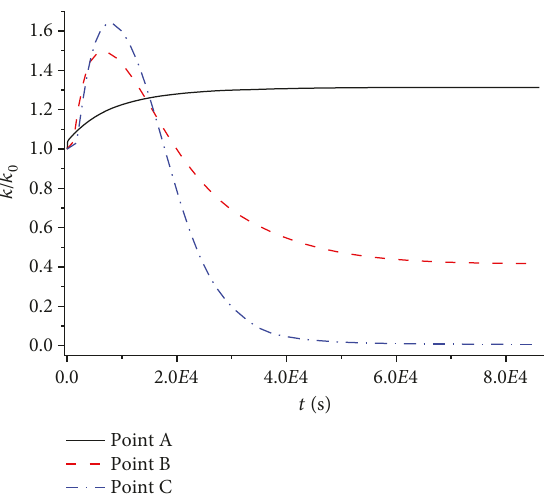
with time at speci fi c 0